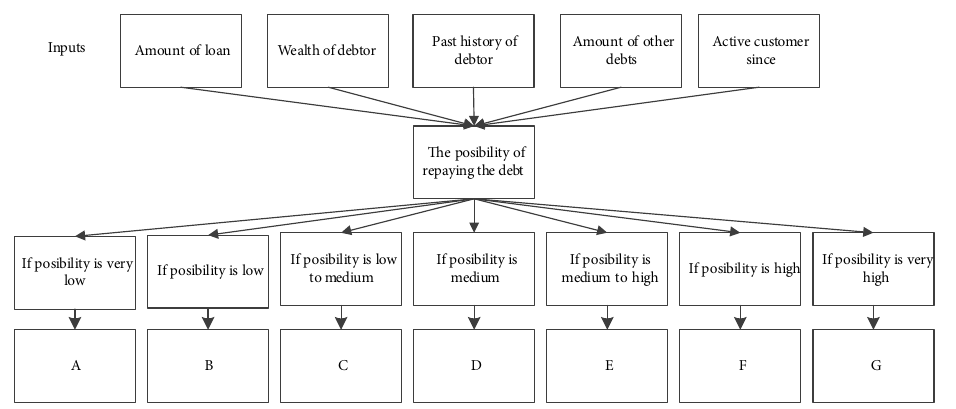
Figure 5. Fuzzy rule based inference system for credit